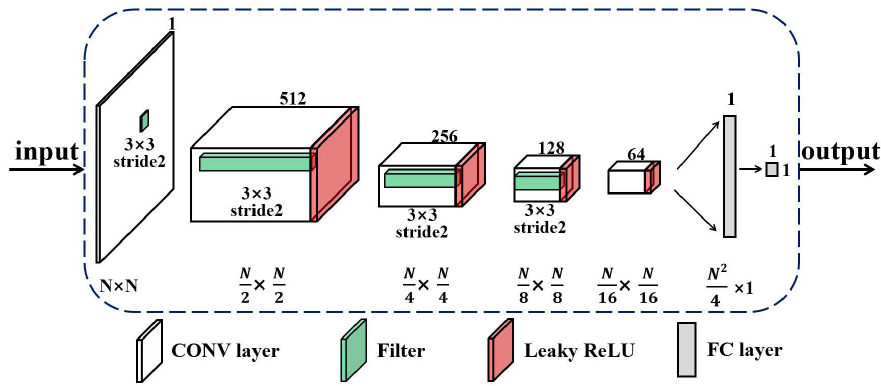
Figure 6. The structure of the